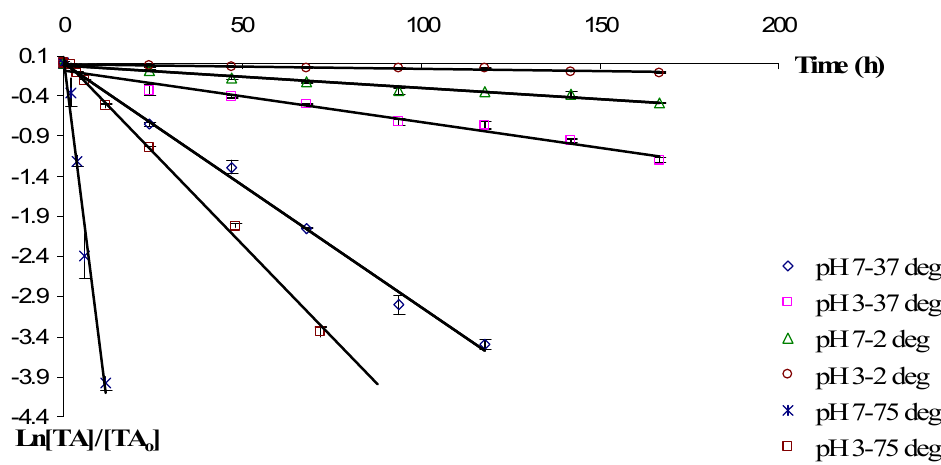
Figure 1. Degradation of anthocyanins in cranberrybush fruits aqueous extract during storage at different temperature and pH values (Vertical lines represent SD, n =